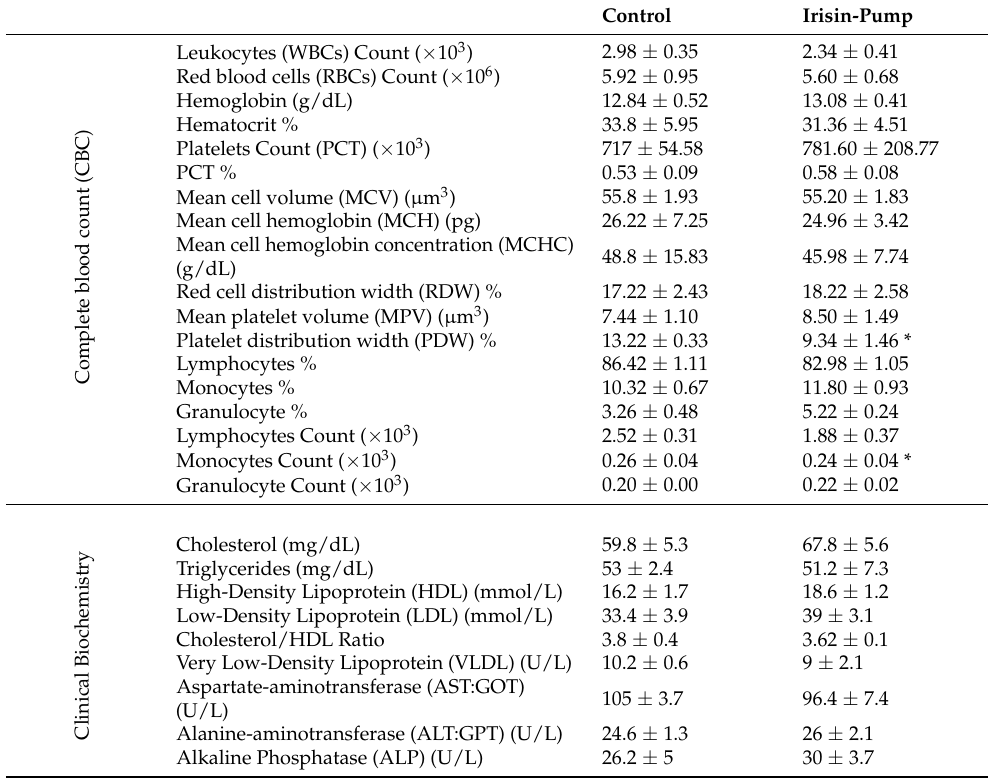
Table 1. Complete blood count (CBC) and serum clinical biochemistry. Data presented as Mean ± SEM; * p < 0.05; analyzed using Mann–Whitney non-parametric